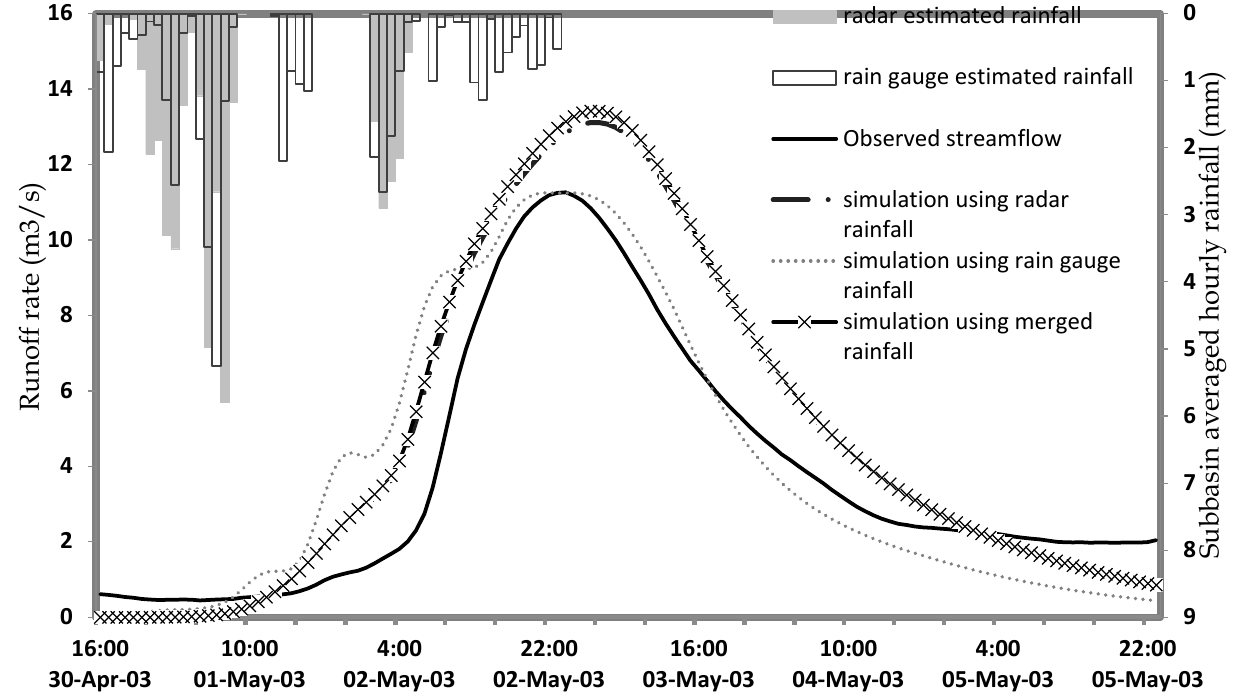
Figure 15. Comparison of estimated and observed hydrographs using different rainfall estimates for the 30 April 2003 event with SCS modeling option.